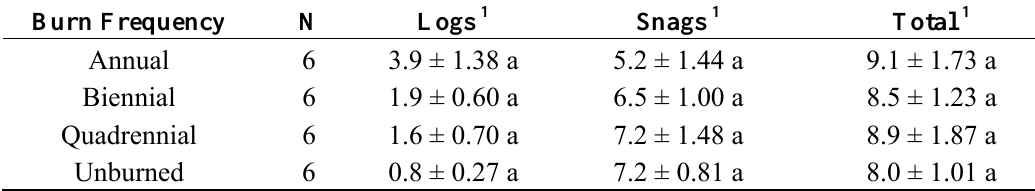
(logs > 10 cm dia.) on longleaf pine plots on the Osceola National Forest (Baker County, Florida) burned at varying frequencies over a 40 year